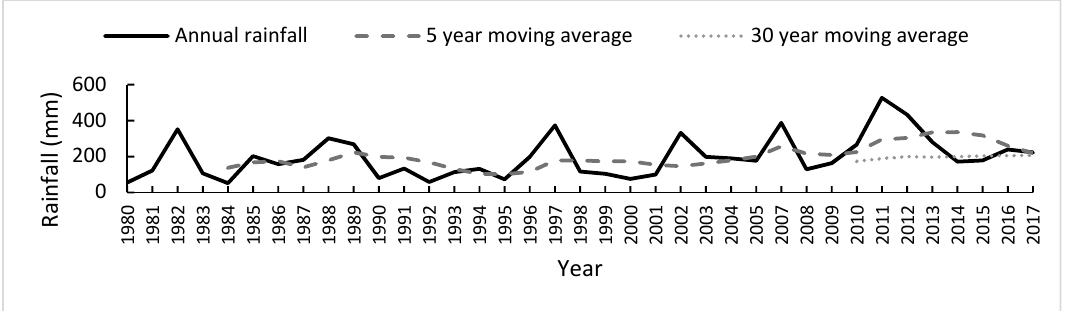
Figure 2. Total annual rainfall in Turkana (source: Kenya Meteorological Department, Lodwar meteorological station record).